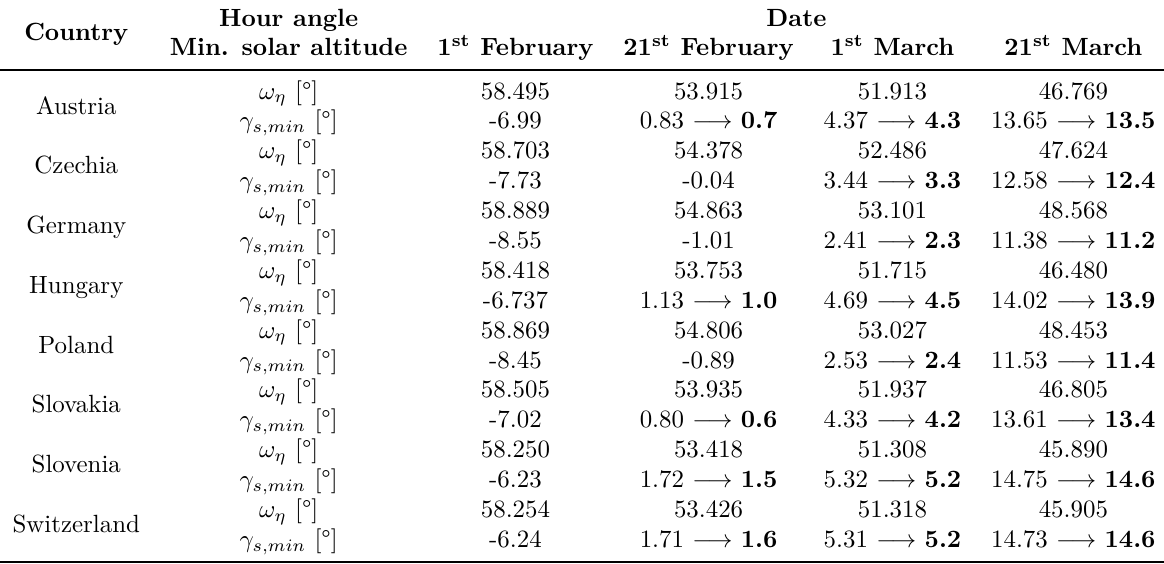
Table 2. Minimum solar altitude γ